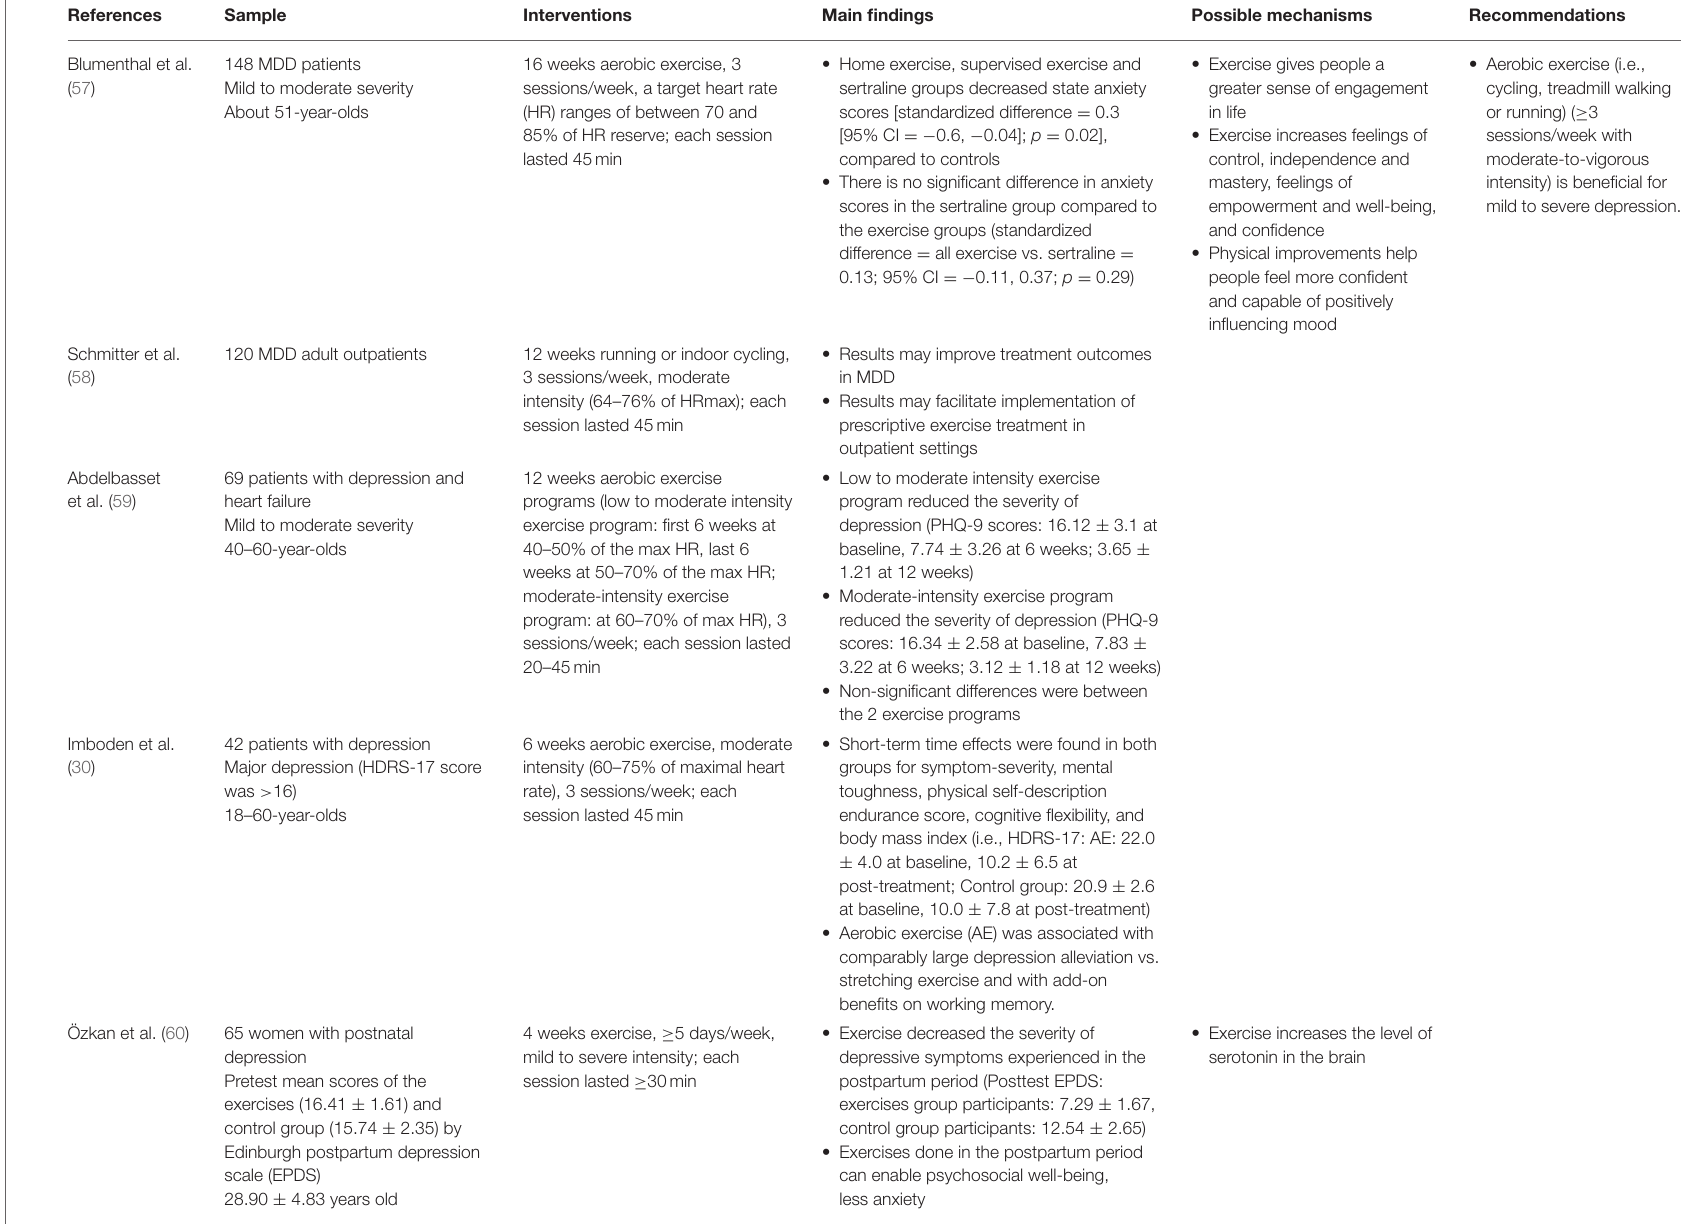
TABLE 1 | The effects of recent exercise interventions in patients with diagnosed